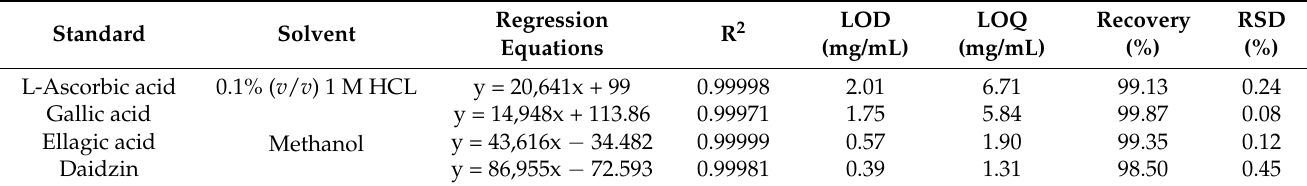
Table 3. Parameter of calibration curves and recovery rates of the reference standard